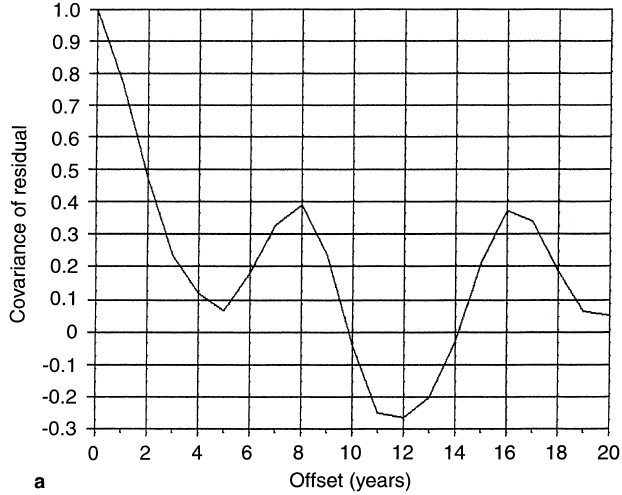
Fig. 10a. Covariance